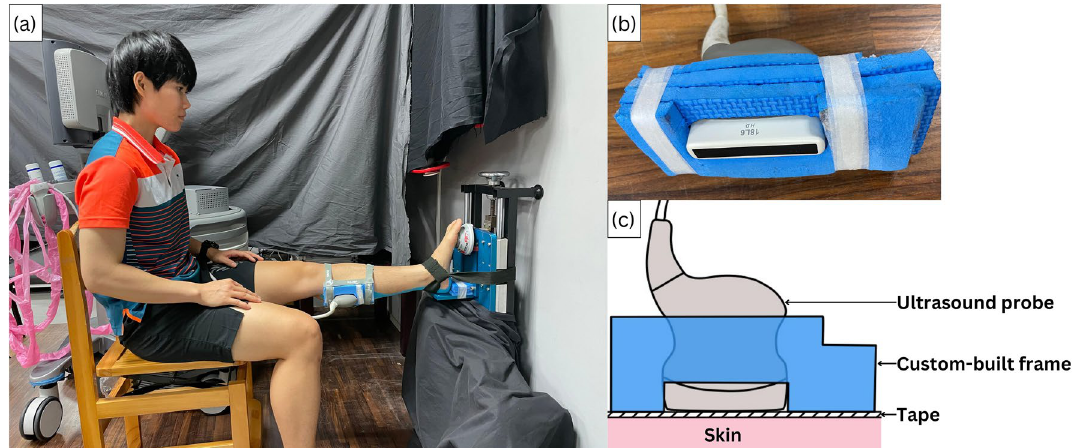
Figure 4. Maximal voluntary isometric plantar flexion task ( a ), the custom-built frame ( b ) and the cross- section view at the intersection of ultrasound probe and the tape ( c